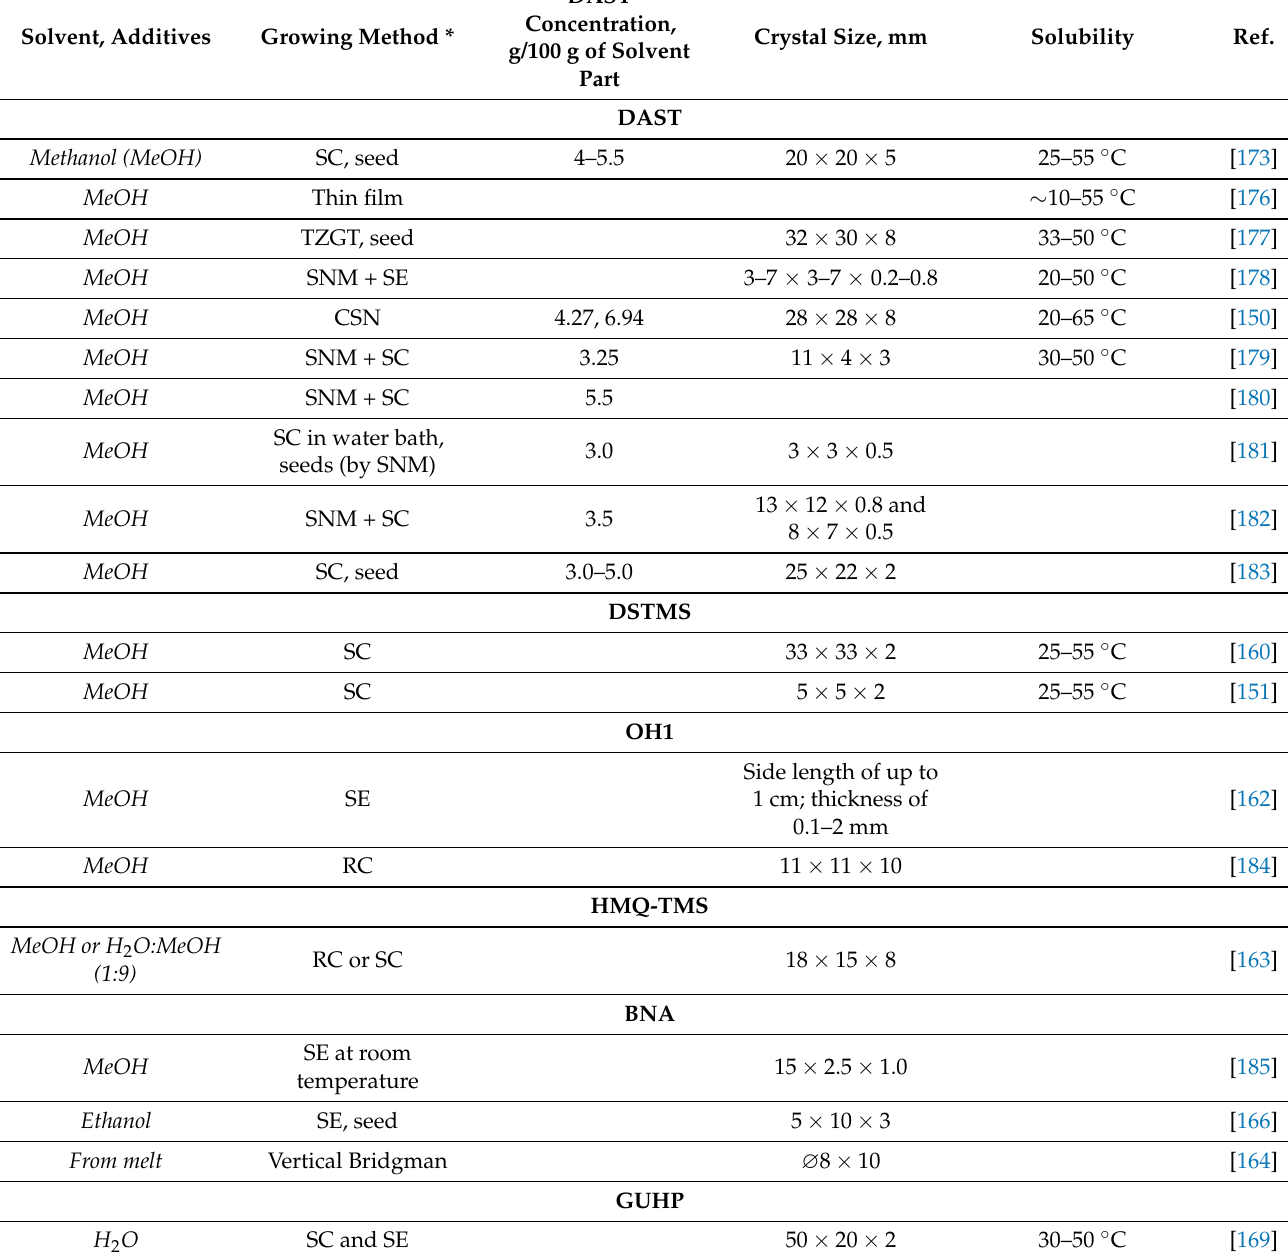
Table 5. Parameters of crystal